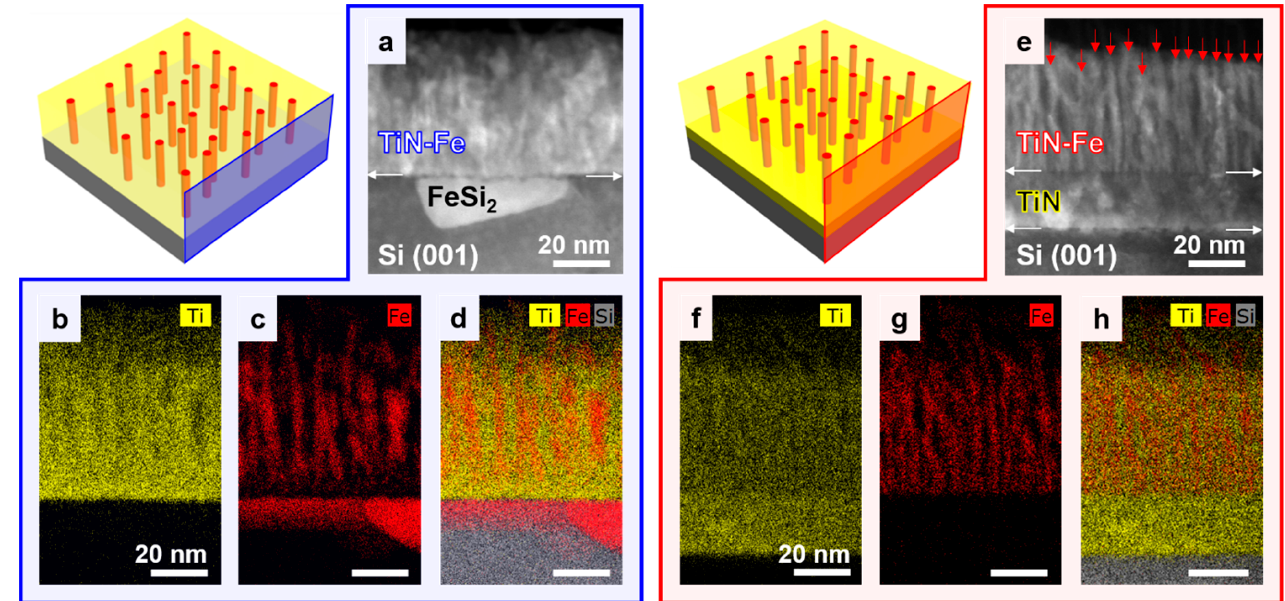
Figure 3. The cross-sectional nanostructure of the TiN–Fe vertically aligned nanocomposites revealed by STEM with EDS. The STEM image of ( a ) TiN–Fe deposited on bare Si and corresponding ( b ) Ti, ( c ) Fe, and ( d ) composite Ti, Fe, and Si elemental maps. The STEM image of ( e ) TiN–Fe deposited on TiN-buffered Si and corresponding ( f ) Ti, ( g ) Fe, and ( h ) composite Ti, Fe, and Si elemental maps.